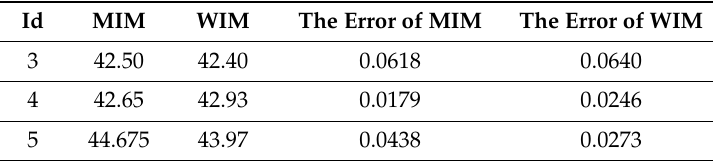
Table 4. The interpolation results of